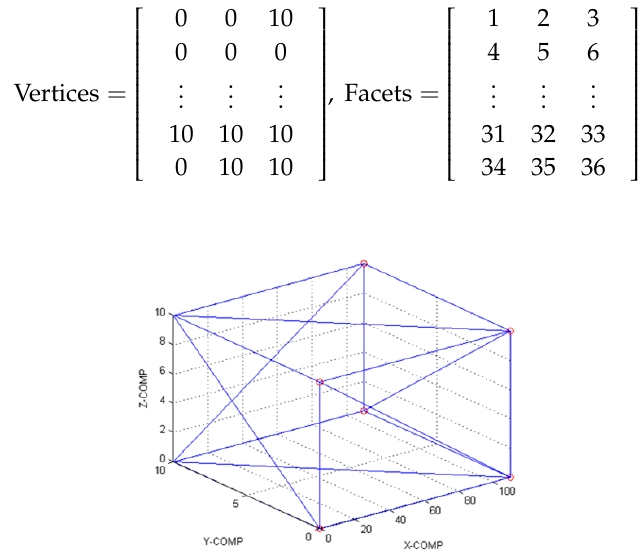
Figure 3. A cube with vertices and facets indices. A triangulation of vertices is represented using edges, and these combinations can be given in matrices form.